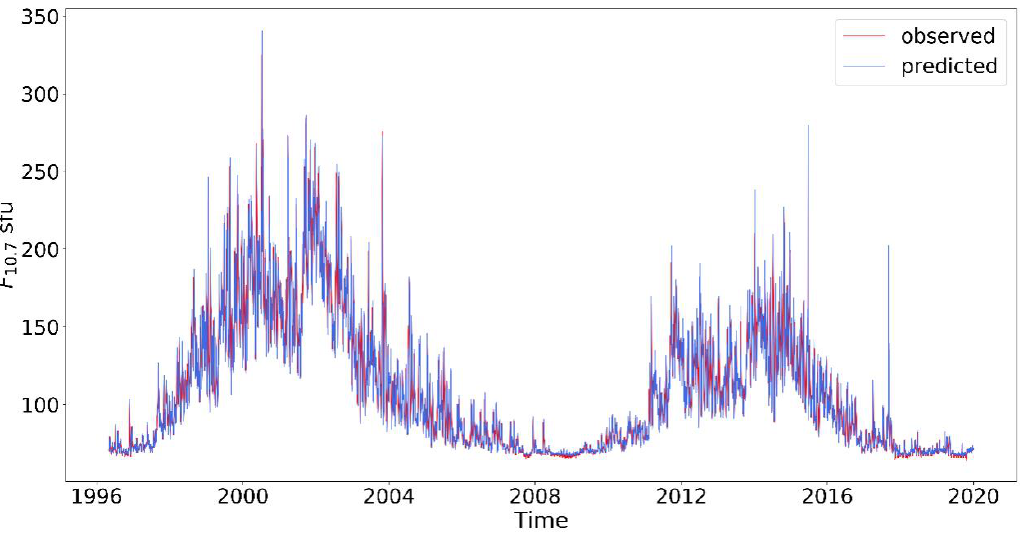
Figure 4. Three-steps-ahead (3-day forecast) prediction of the LSTM model with the observed (red line) and predicted (blue line) F 10 . 7 from 1996 to 2019.